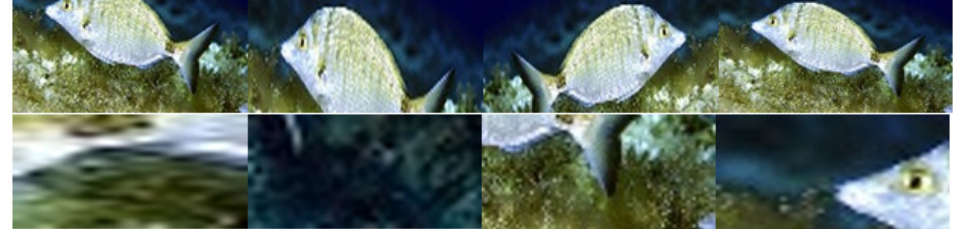
Figure 12. Augmenting the initial dataset, with the image variants that are recognized as displaying Figure 13. The landmarks are used in the deep learning approach.